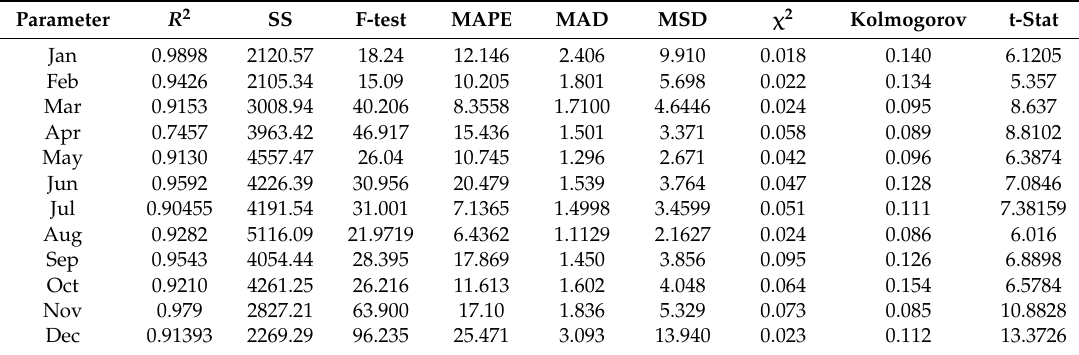
Table 4. Monthly statistical parameters for evaluating the Weibull and Rayleigh